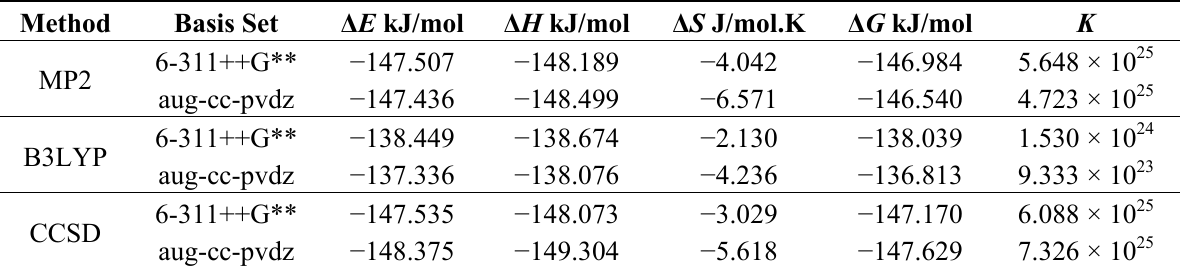
Table 5. MP2, B3LYP and CCSD methods with 6-311++G** and aug-cc-pvdz basis sets zero-point Reaction Energies, Enthalpies, Entropies, Free Energies Changes